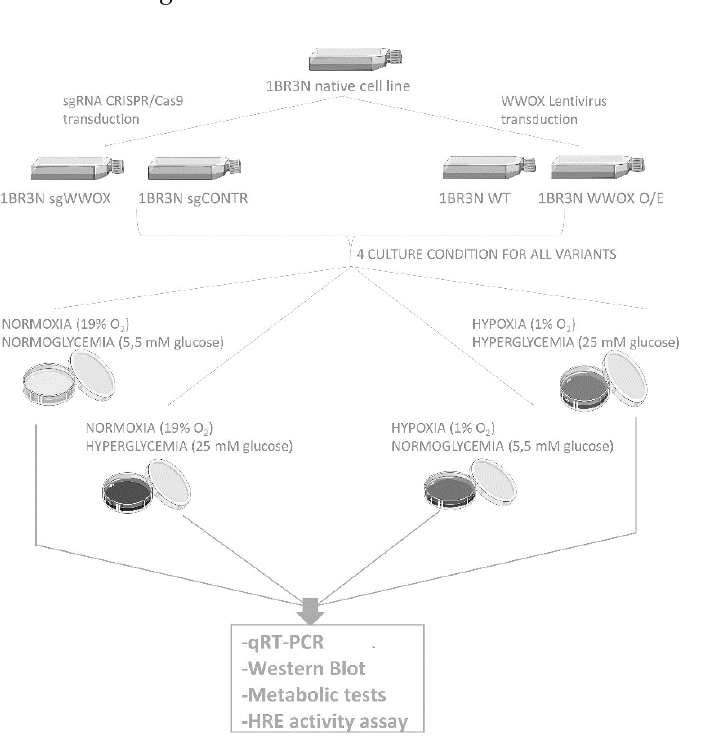
Figure 12 . The scheme of experiment